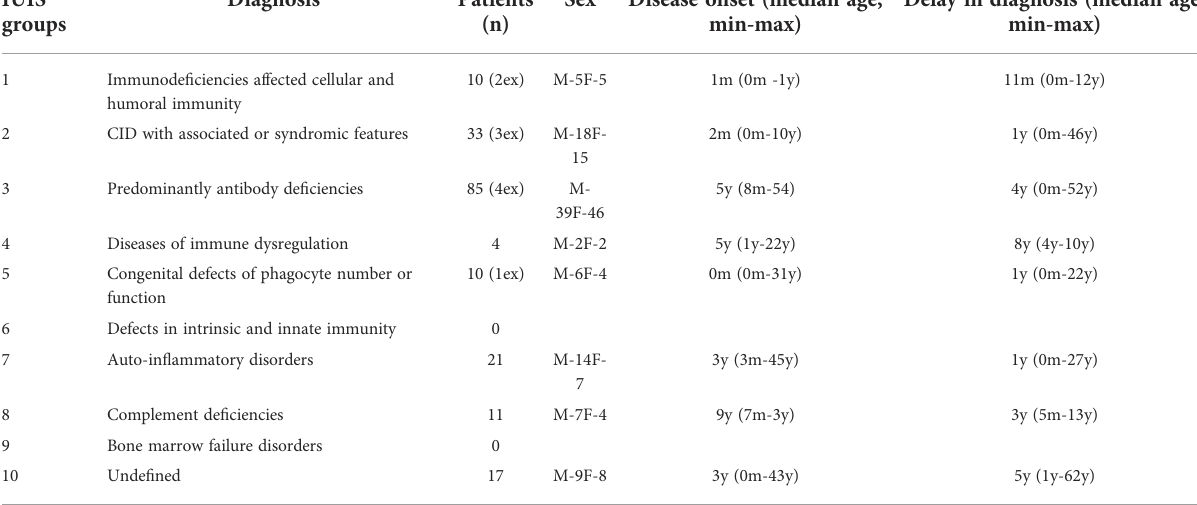
TABLE 1 Distribution of patients from the National PID Registry by main disease groups according to IUIS classi fi cation, sex, median age of onset and median age at diagnosis (diagnostic delay). IUIS